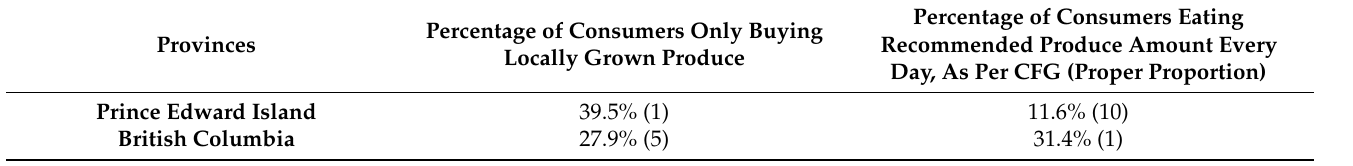
Table 1. Purchasing habits for produce per